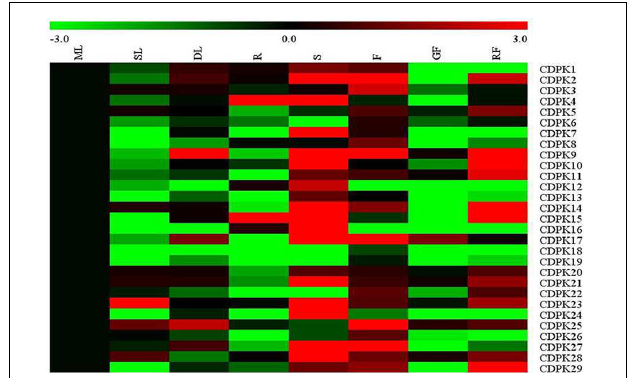
FIGURE 5 | Expression profiles of CDPK genes across different tissues in tomato. ML, mature leave; SL, senescence leave; DL, developing leave; R, root; S, stem; F, flower; GF, green fruit; RF, red fruit. The color scale stands for the relative signal intensity values.